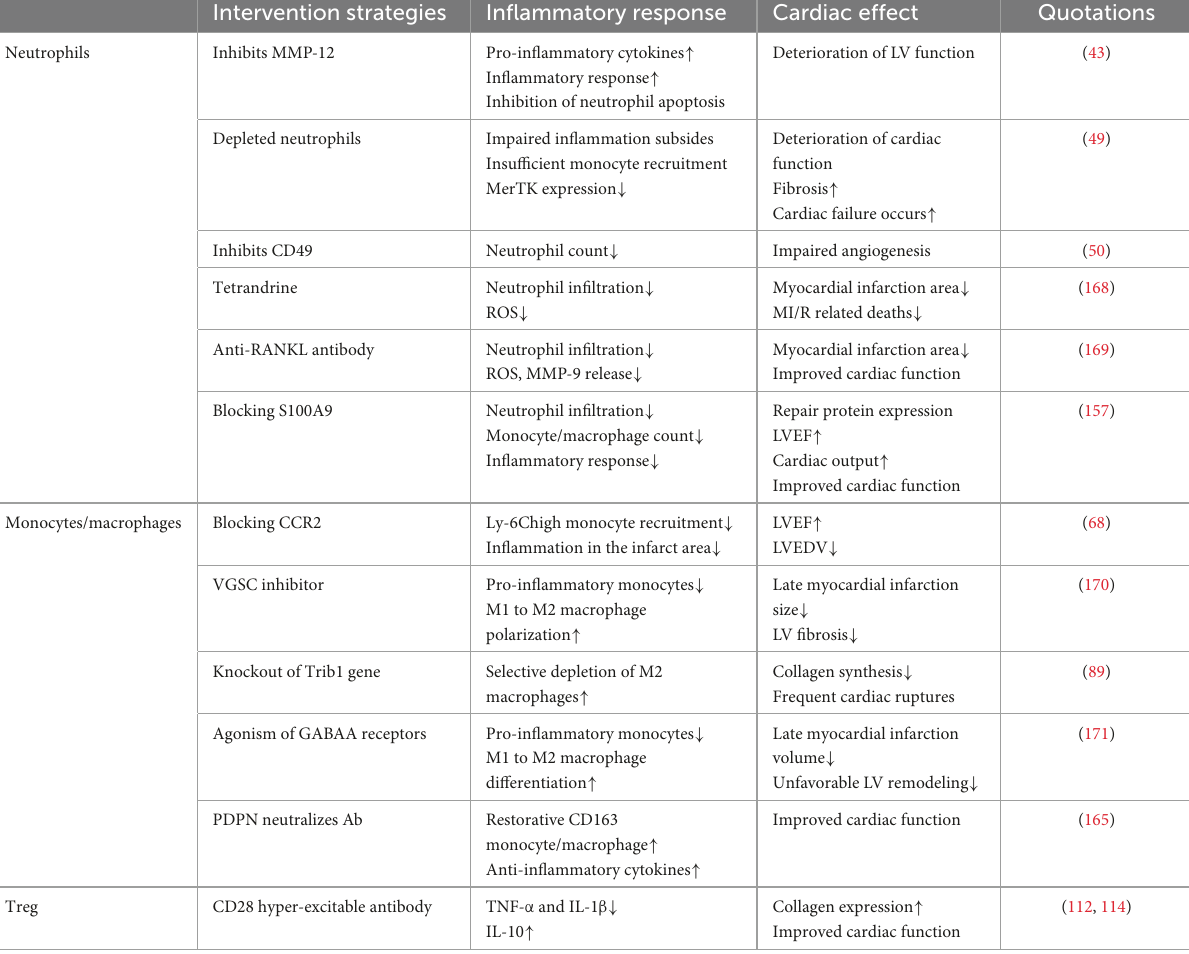
TABLE 1 Experimental evidence for immune cell-mediated inflammation and cardiac